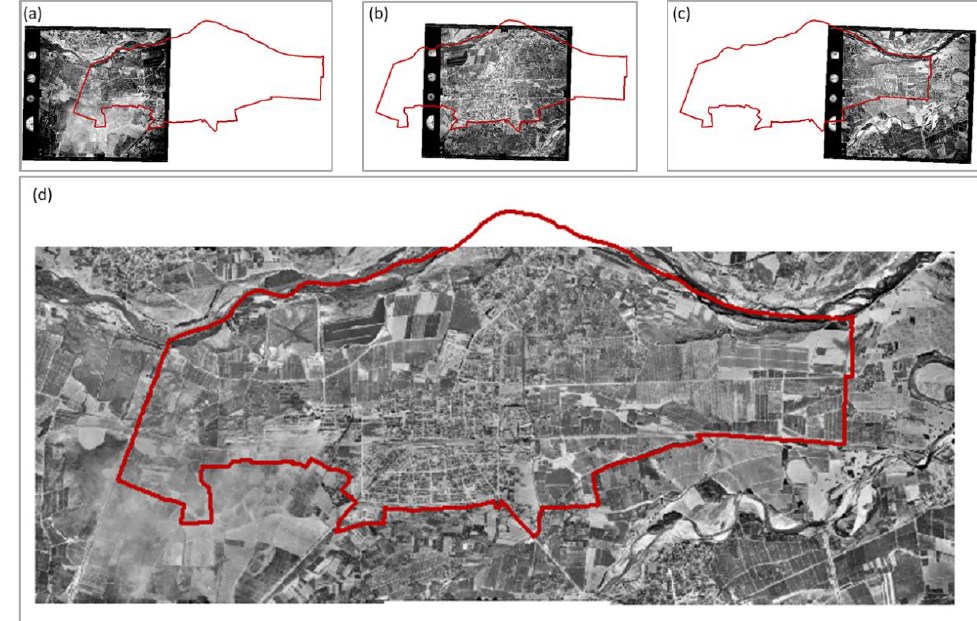
Figure 8. ( a – c ) Aerial photographs from 1965 covering parts of Stamboliyski, and ( d ) mosaicked 1965 Stamboliyski aerial photograph. Red vector illustrates the boundaries of the Stamboliyski town.